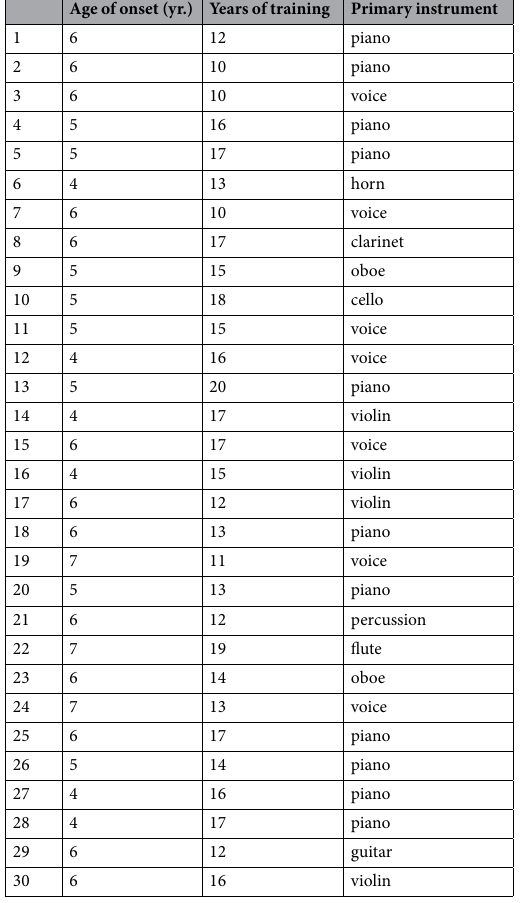
Table 2. Overview over the musical experience of the musicians participating in the